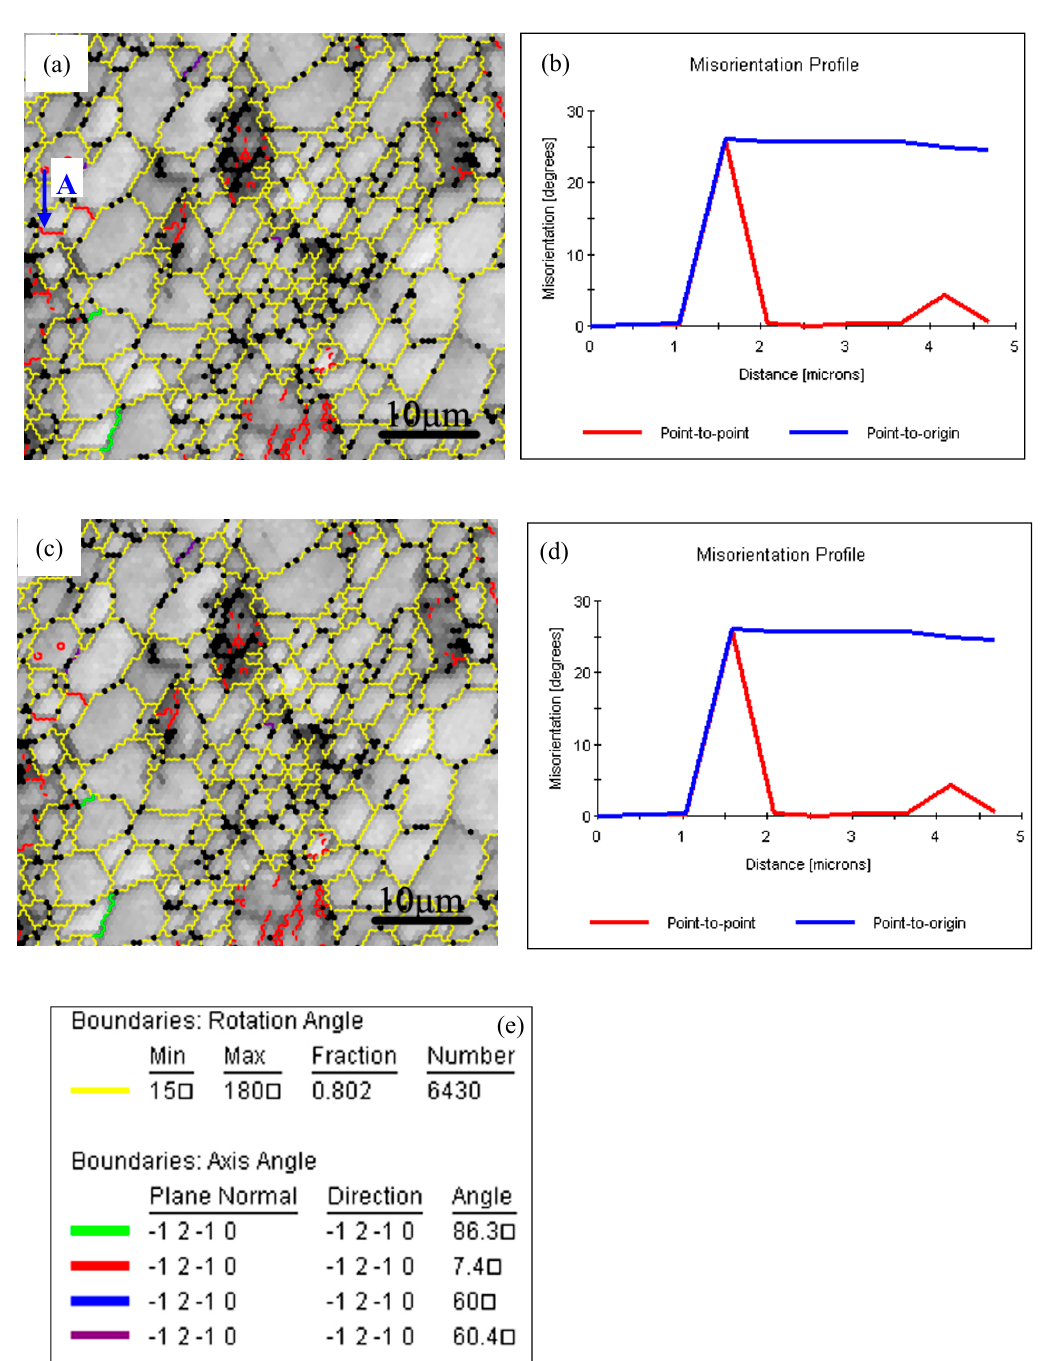
Figure 8. Twin characteristics in the extruded alloy compressed at room temperature. ( a ) and ( c ) twining morphology; ( b ) and ( d ) line profiles of the misorientation angle along the direction of arrow A; ( e ) the colors of twins with different misorientation.